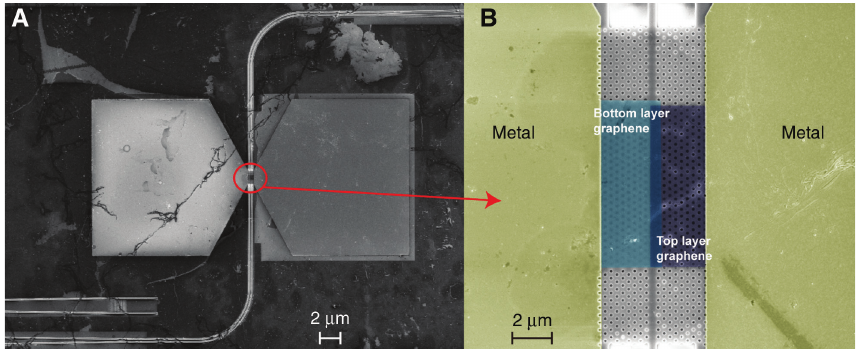
Figure 4: Characterization of the fabricate double-layer graphene modulator. (A) SEM image of the modulator. (B) Detailed structure of the active